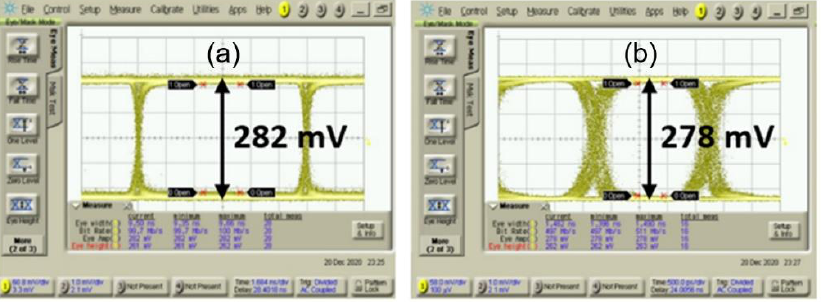
Figure 12. Measured eye-diagrams at ( a ) 100 Mb/s, (b) 500 Mb/s for 50 µA pp 2 31 -1 PRBS input.